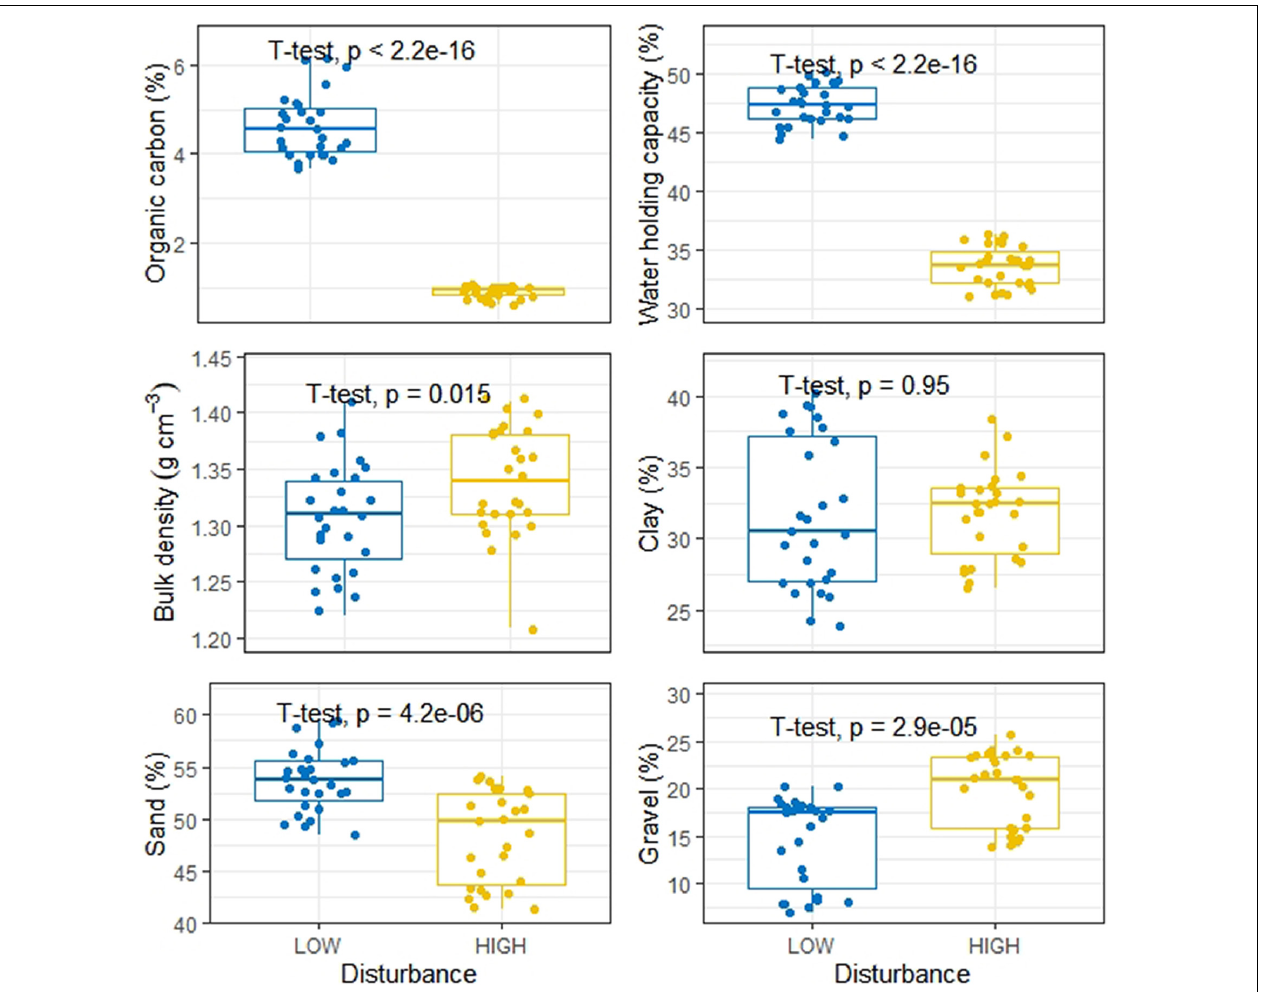
FIGURE 3 | Boxplot showing distribution of soil properties at low and high disturbed